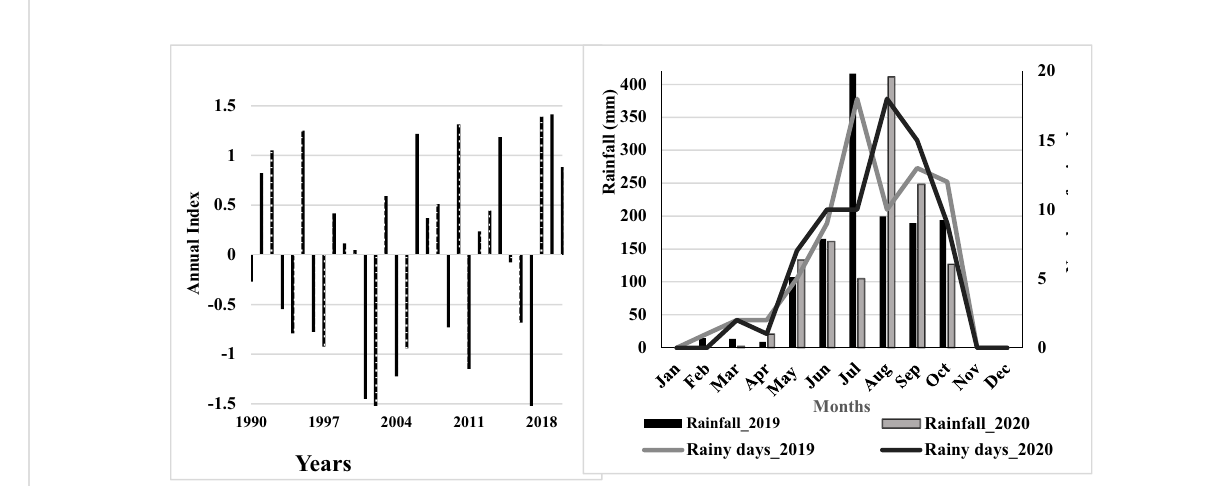
FIGURE 2 Annual rainfall indexes from 1990 to 2020 (left), and rainfall variation in 2019 and 2020